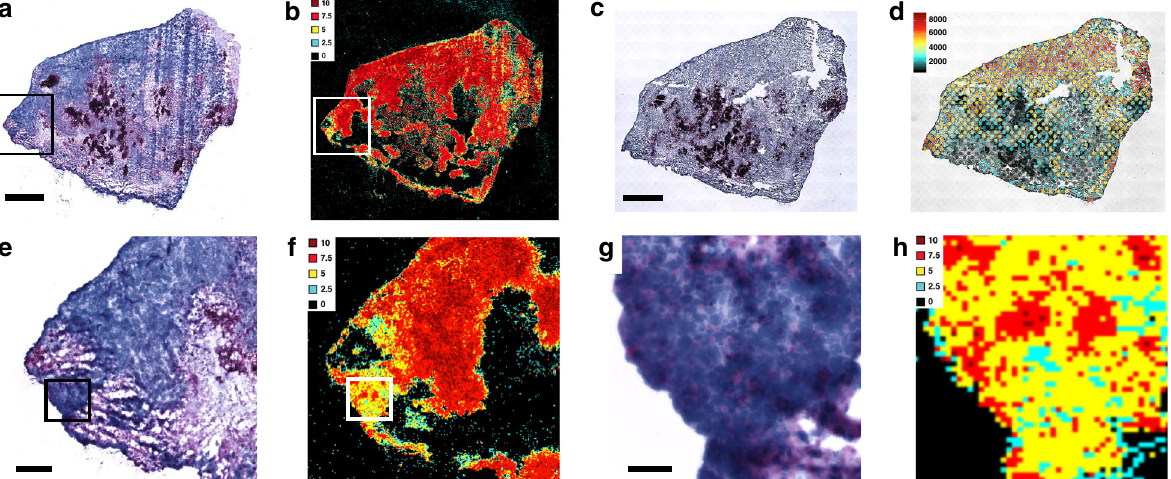
Fig. 4 Specimen evaluation of spatial transcriptome quality with sRIN assay. a HE image (scale bar: 1 mm) and b sRIN heat map of a malignant childhood brain tumor diagnosed as anaplastic medulloblastoma grade IV ( n = 4, technical replicates), boxes enclose regions shown in close-up. c HE image (scale bar: 1 mm) and d ST analysis showing unique genes, of the same childhood brain tumor ( n = 2, technical replicates). Close-up of e HE (scale bar: 200 µ m) image and f sRIN heat map of the same childhood brain tumor where deep blue areas represent intact cell rich tumor and in light purple areas the tumor is necrotic. The sRIN heat map show areas of varied sRIN values in the tumor areas and no sRIN values in necrotic areas, boxes enclose regions shown in close-up. Close-up of g HE (scale bar: 40 µ m) image and h sRIN heat map of the same childhood brain tumor show areas of similar HE staining pattern and varied sRIN